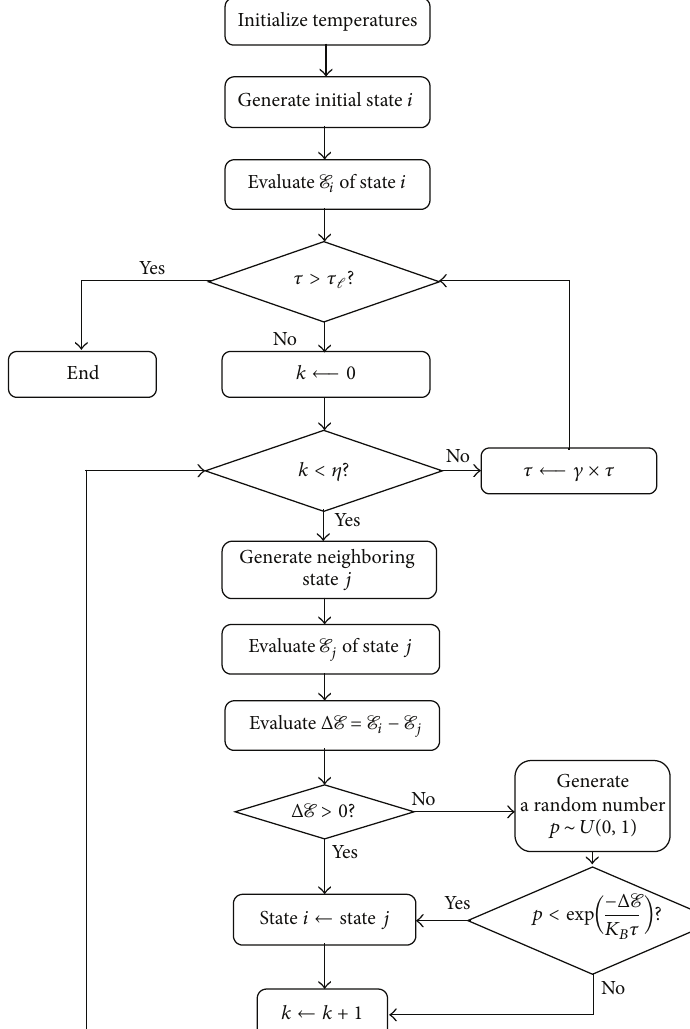
Figure 5: Flow chart of our SA